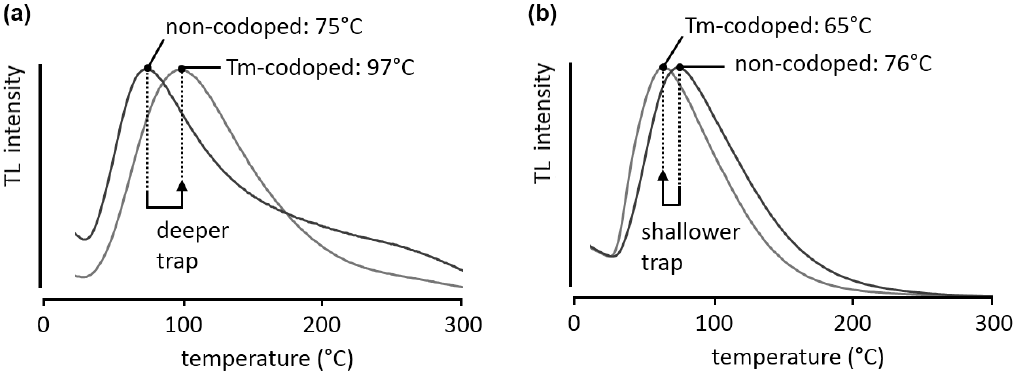
Figure 5. Normalized TL glow curves for (a) Ca (b) Ba Si N :Eu and Ba 2 5 8 2 minutes, at an excitation wavelength of 300 nm. The heating rate β was 2.5